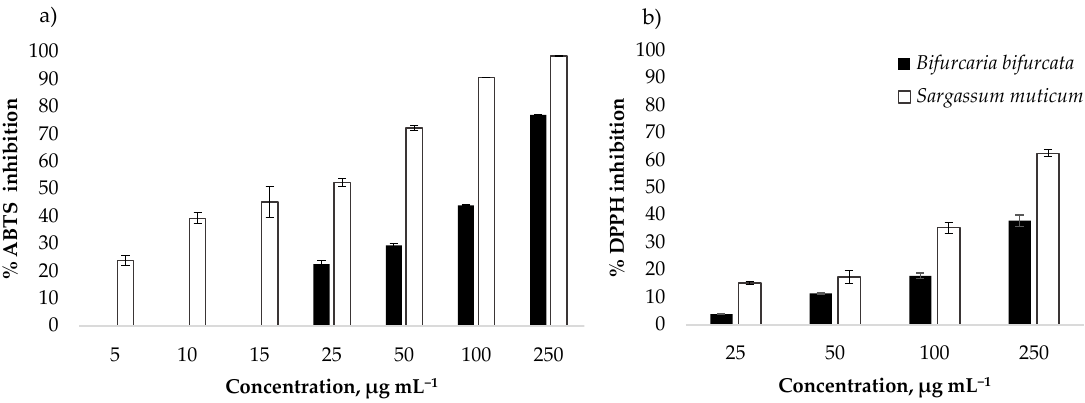
Figure 9. Free radical-scavenging activity (%) on 2,2´-azino-bis-3-ethylbenzothiazoline-6-sulfonic acid radical cation (ABTS) ( a ) and 2,2-diphenyl-1-picrylhydrazyl radical (DPPH) assays ( b ) radicals of B. bifurcata ( a ) and S. muticum lipid extracts. Each value is expressed as mean ± standard deviation ( n = 3). • + For B. bifurcata , 50% of inhibition (IC 50 ) of ABTS radical was attained at a concentration of − 1 − 1 • 134.19 ± 2.12 µ g mL (IC 50 ), representing a TE of 100.33 ± 1.57 µ mol g , while for DPPH , only 25% − 1 of inhibition (IC 25 ) was attained at a concentration of 155.00 ± 3.96 µ g mL representing a TE of 74.89